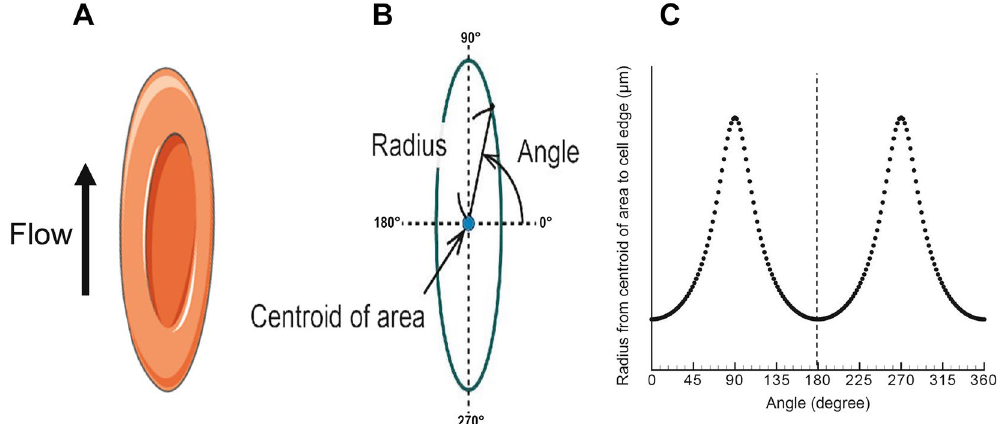
Figure 1. Proposed method for red blood cell (RBC) asymmetrical analysis: Following identification of RBC in shear flow ( A ), each cell must be binarised, edges detected, and analysed for centroid identification ( B ). The radius from the centroid is subsequently determined for each angle around the circumference of the cell and plotted ( C ); the central nadir is mathematically determined by splitting the dataset into left and right sides, each half is analysed for asymmetry by determining difference in area under the curve. For cells with theoretically “perfect” symmetry, this value would be